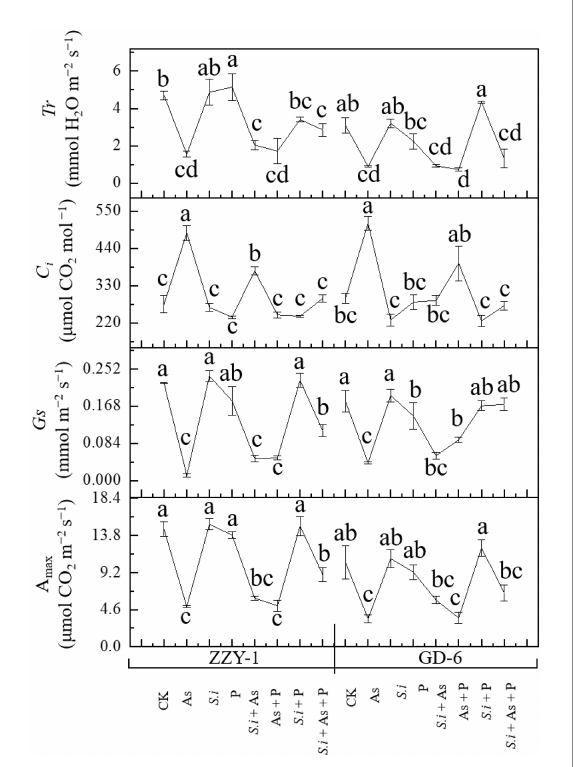
FIGURE 2 Photosynthetic attributes of two rice genotypes differing in As accumulation tendency following alone and combined interactions of Serendipita indica symbiosis and phosphorus against As stress. Error bars represent standard errors (n=3). Different letters represent significant difference ( p ≤ 0.05) among the treatments within each